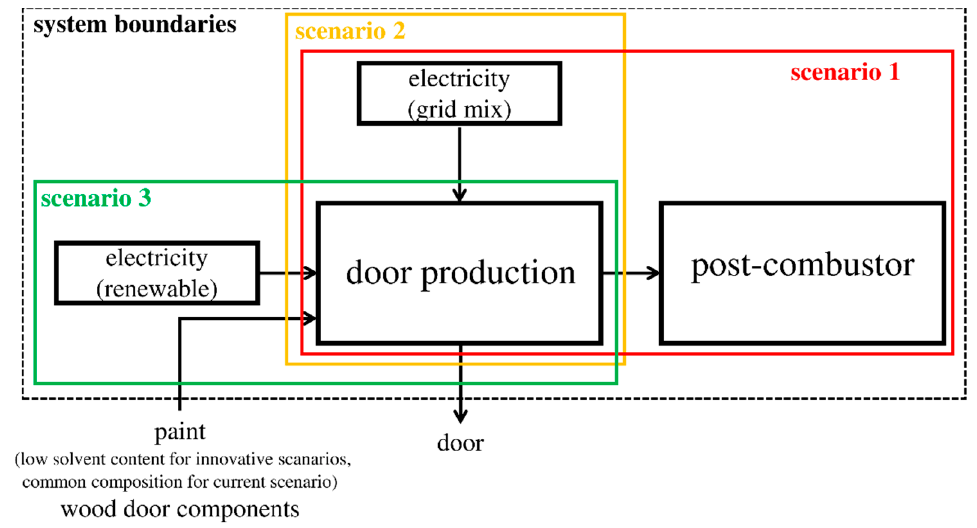
Figure 1. System boundaries considered for the LCA.